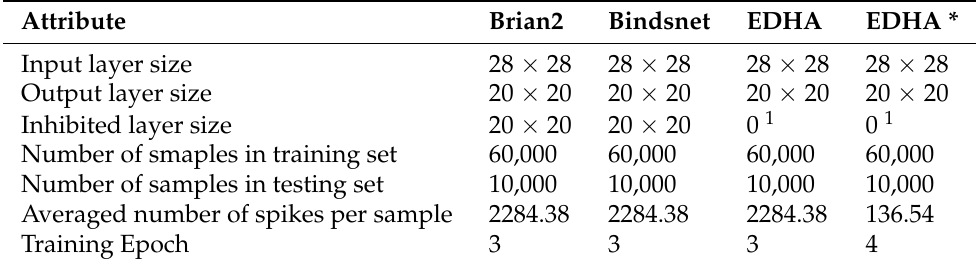
Table 4. Attributes that were used in the speed comparison network. EDHA with asterisk is the EDHA run on the optimized model.